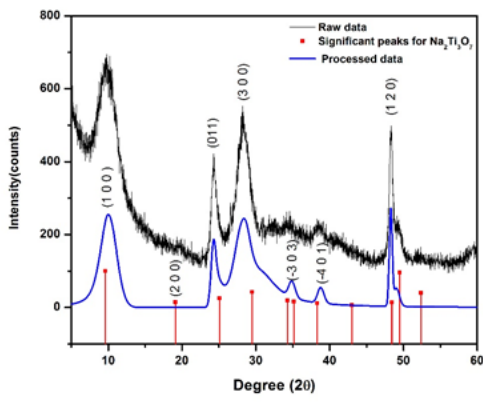
Ti O fibers synthesized by hydrothermal 2 3 7